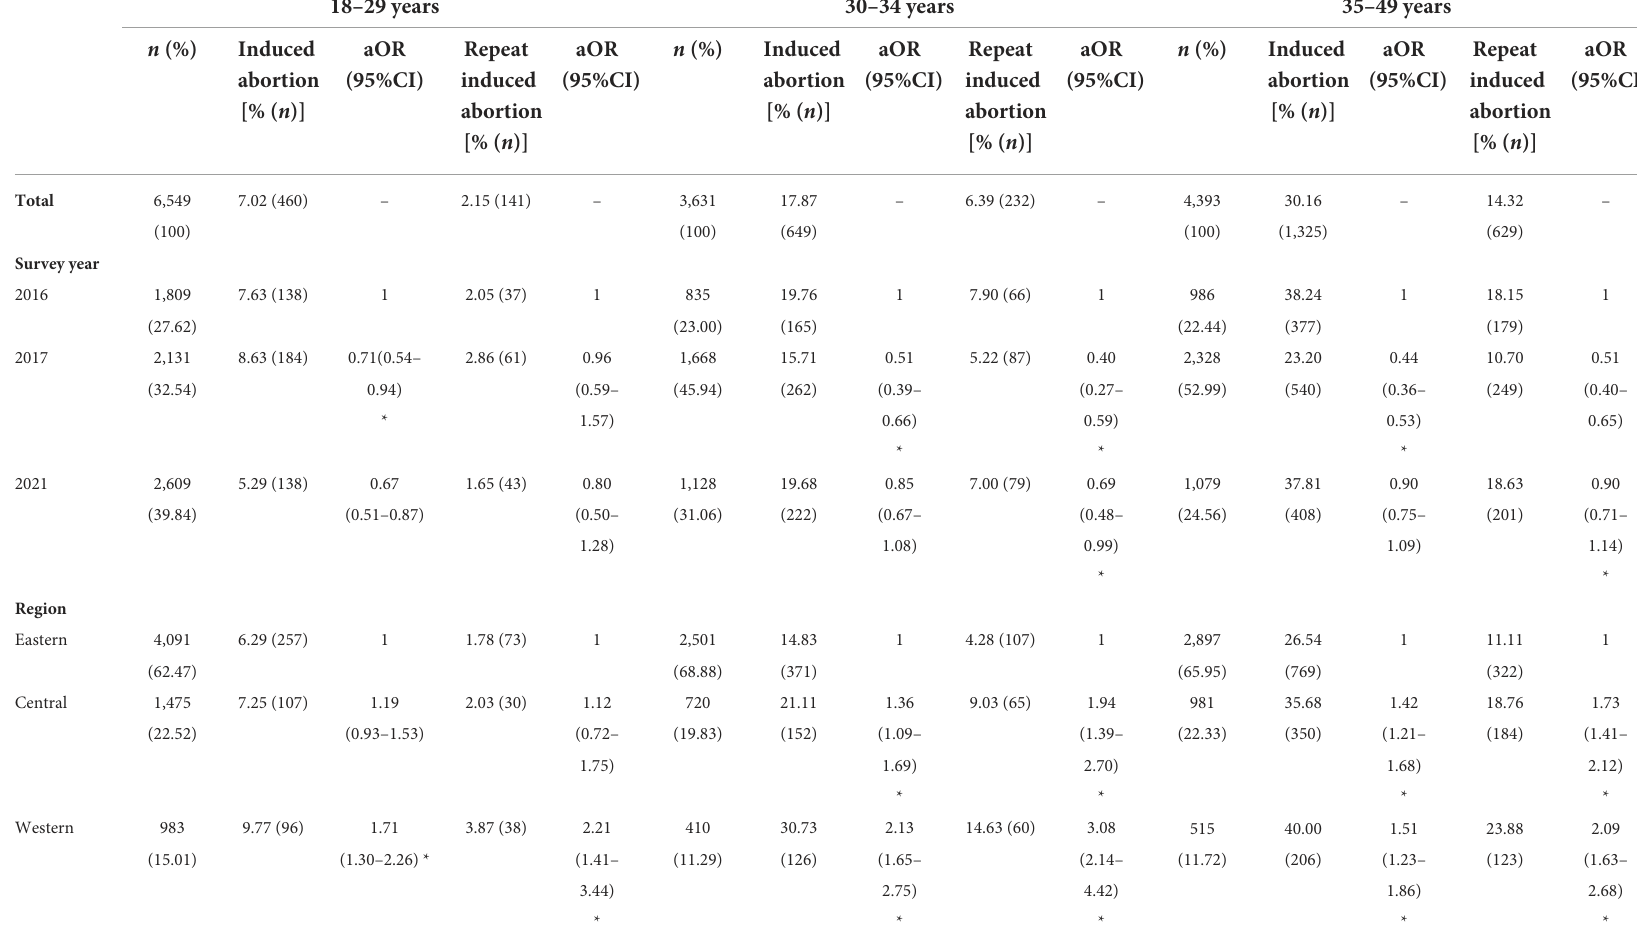
TABLE 3 Factors related to induced abortion and repeated induced abortion in the multivariate model stratified by age